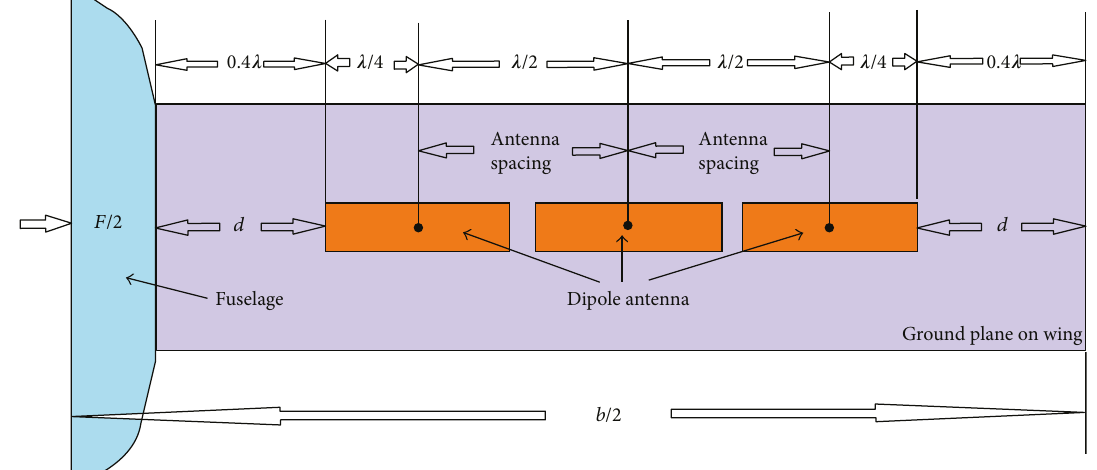
Figure 8: Geometric de fi nition for wing (ground plane) length calculation.